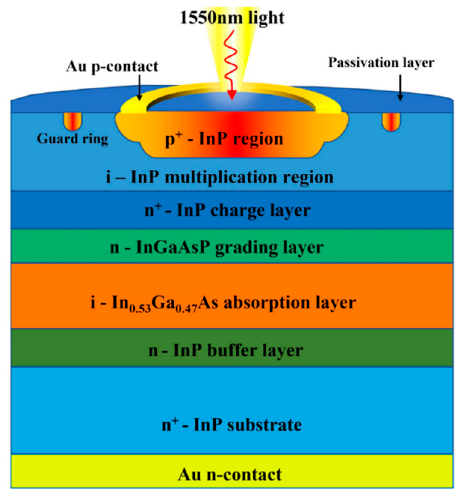
Figure 36. Schematic illustration for InGaAs/InAlAs SAGCM APDs. Reproduced with permission from [91], IEEE, 2022.